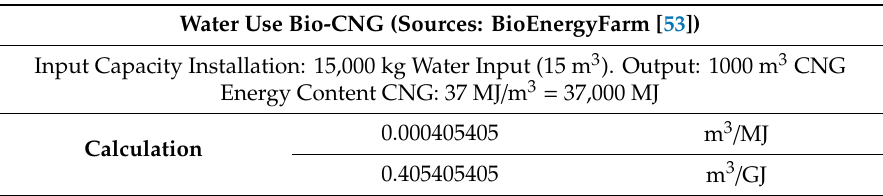
Table A4. Calculation water footprint Bio-compressed natural gas (CNG)—manure. Water Use Bio-CNG (Sources: BioEnergyFarm [53])